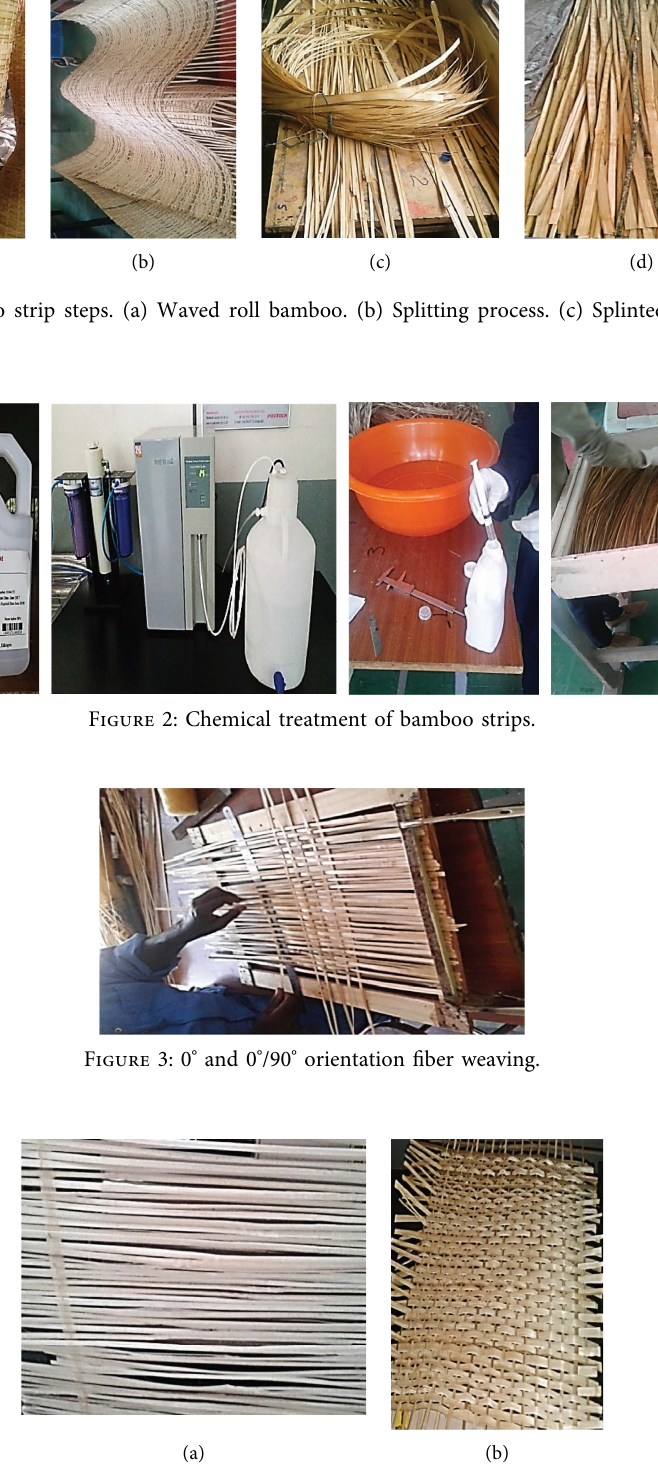
Figure 4: 0 ° and 0 ° /90 ° degree bamboo strip orientation. (a) 0 ° orientation. (b) 0/90 °